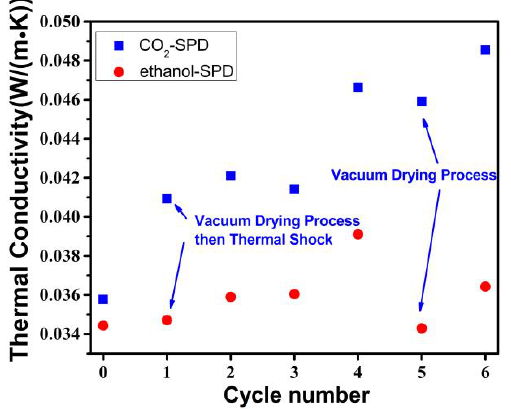
Figure 8. Thermal conductivity changing with cycle times with vacuum drying process.